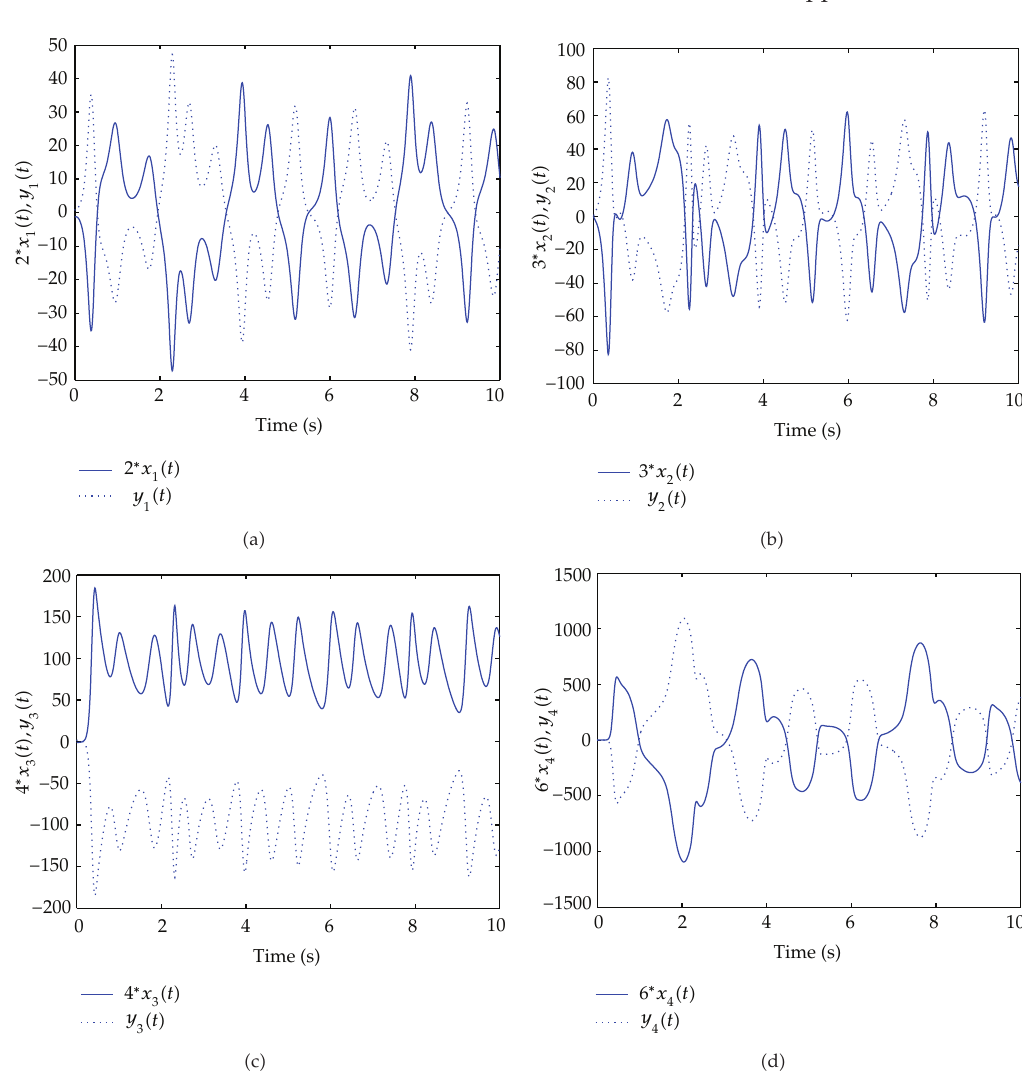
Figure 4: The state synchronization trajectories of the master system (cid:6) 3.1 (cid:7) and slave system (cid:6) 3.2 (cid:7) under control law (cid:6) 3.5 (cid:7)